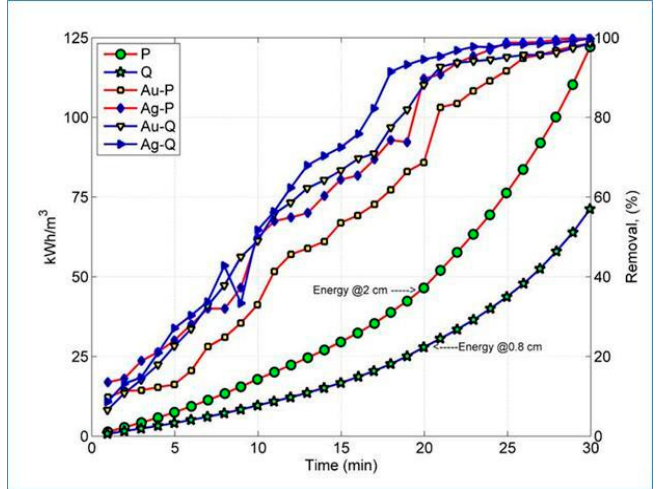
Figure 4. Energy consumption and percent removal of metals versus t r , obtained in the tests at constant current.